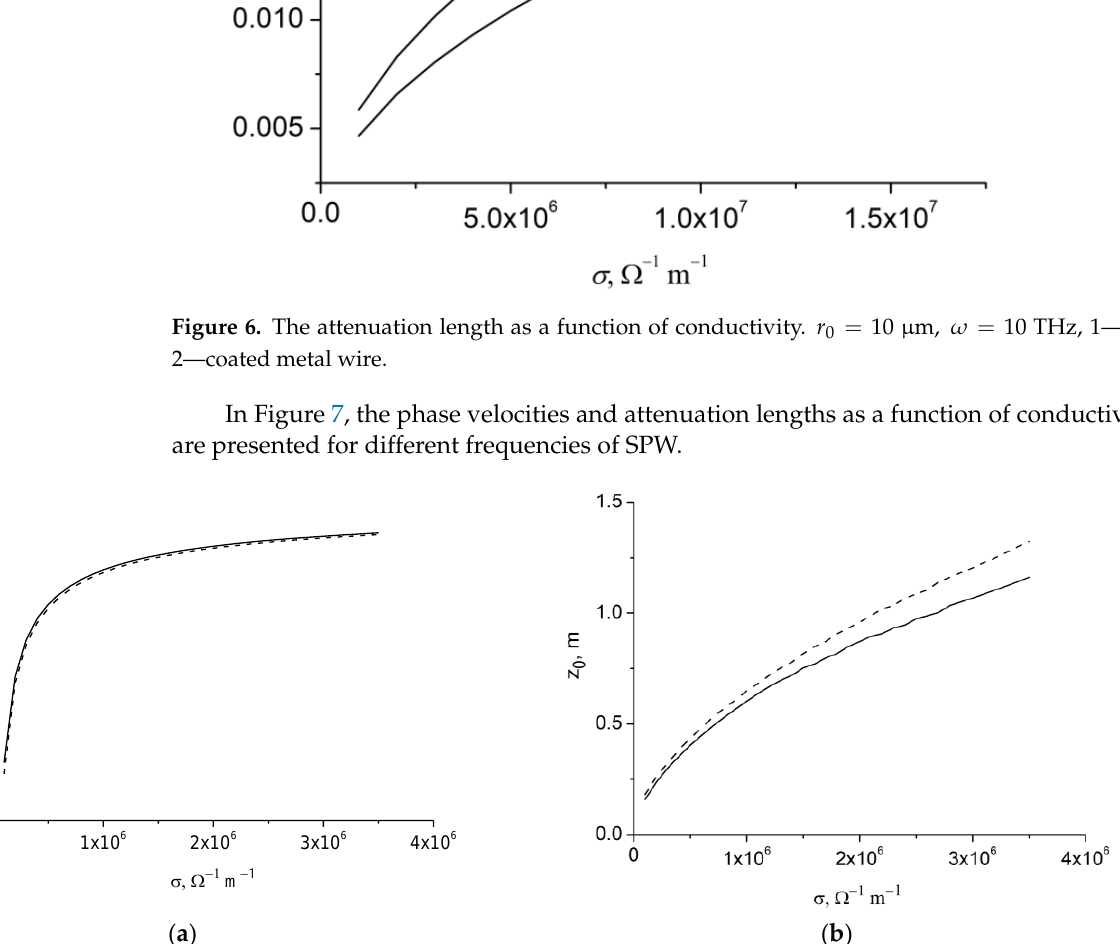
Figure 7. The phase velocity ( a ) and attenuation length ( b ) as a function of conductivity. r 0 = 100 µ m. Dashed line line— ω = 0.9 THz, solid line— ω = 1.0 THz.